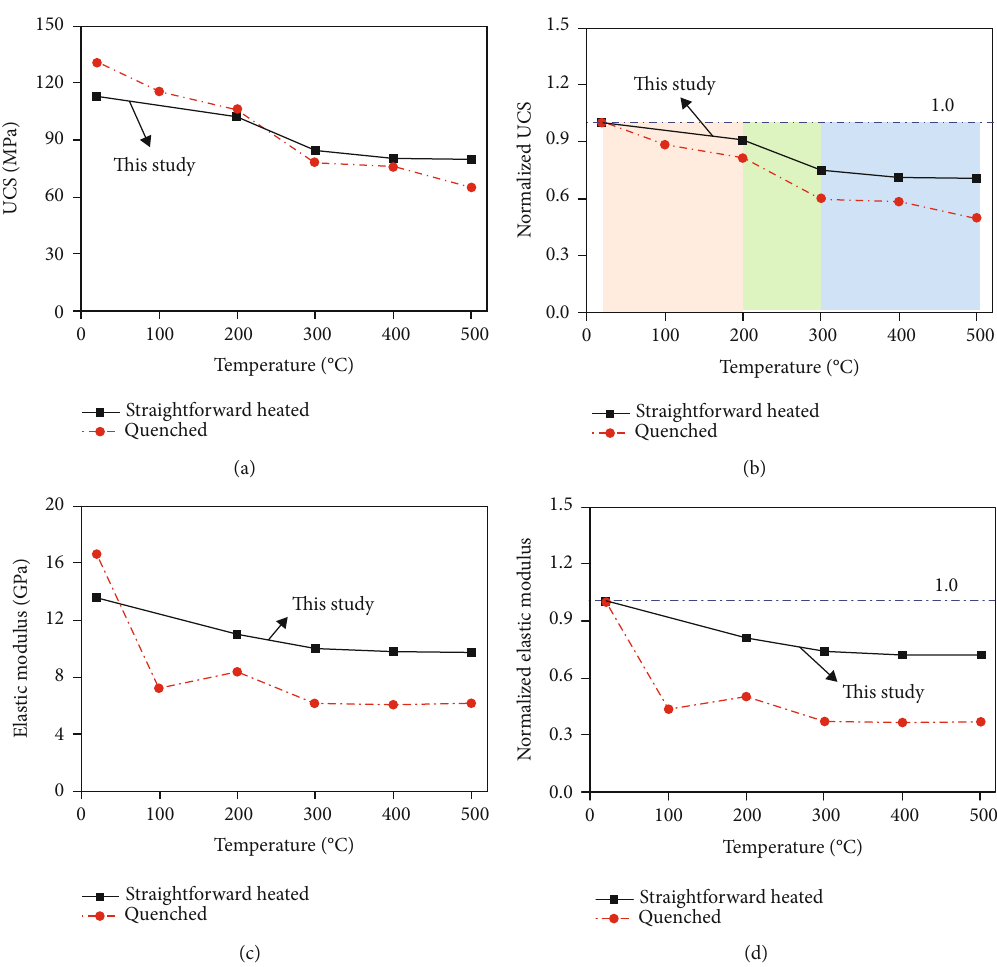
Figure 9: UCS and elastic modules of granite under di ff erent thermal treatments. (a) UCS versus temperature curves; (b) Normalized UCS versus temperature curves; (c) Tangent modulus versus temperature curves; (d) Normalized tangent modulus versus temperature